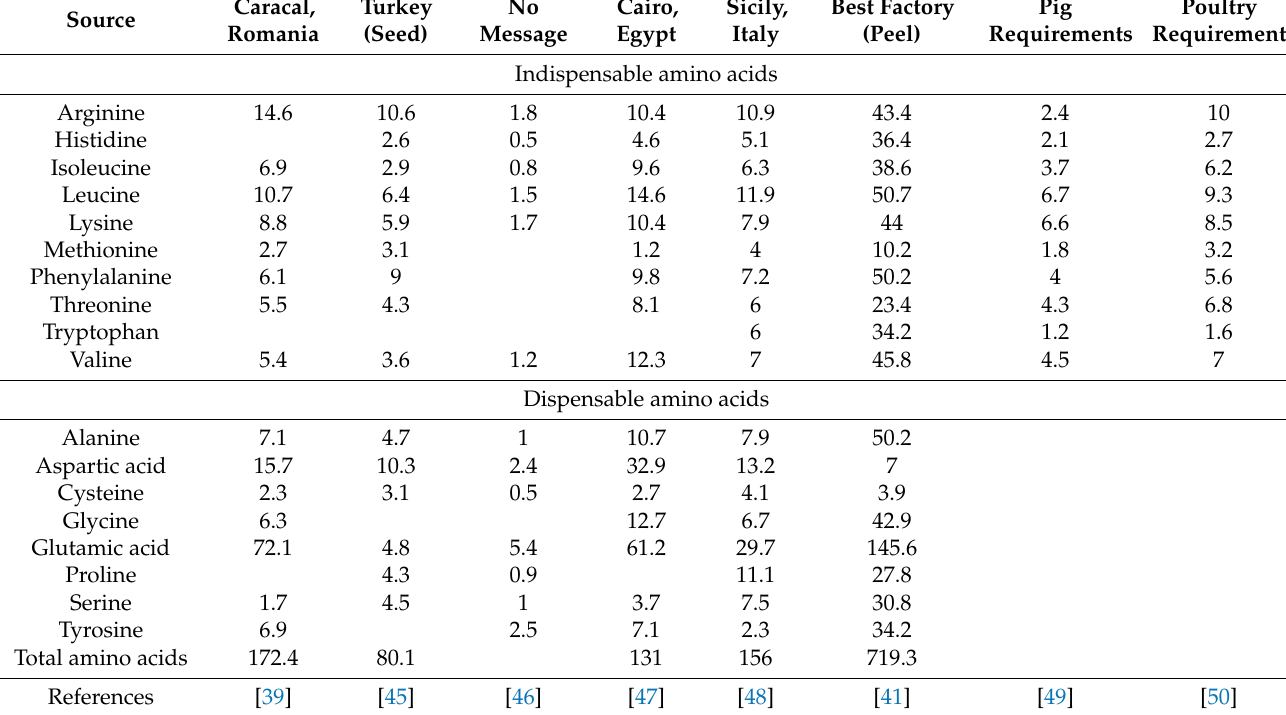
Table 5. Amino acid composition of tomato pomace (g/kg dry matter